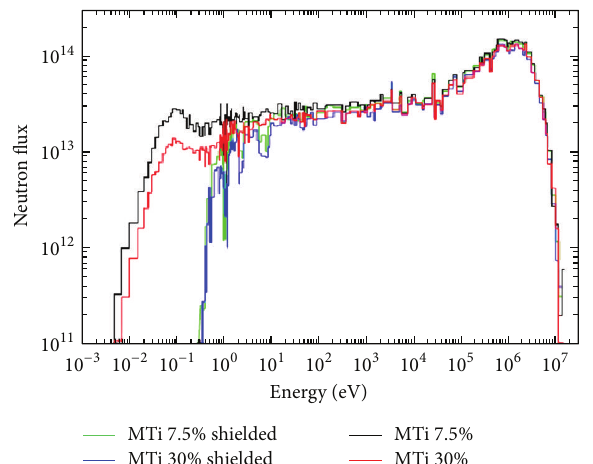
Figure7:Effectofa0.1